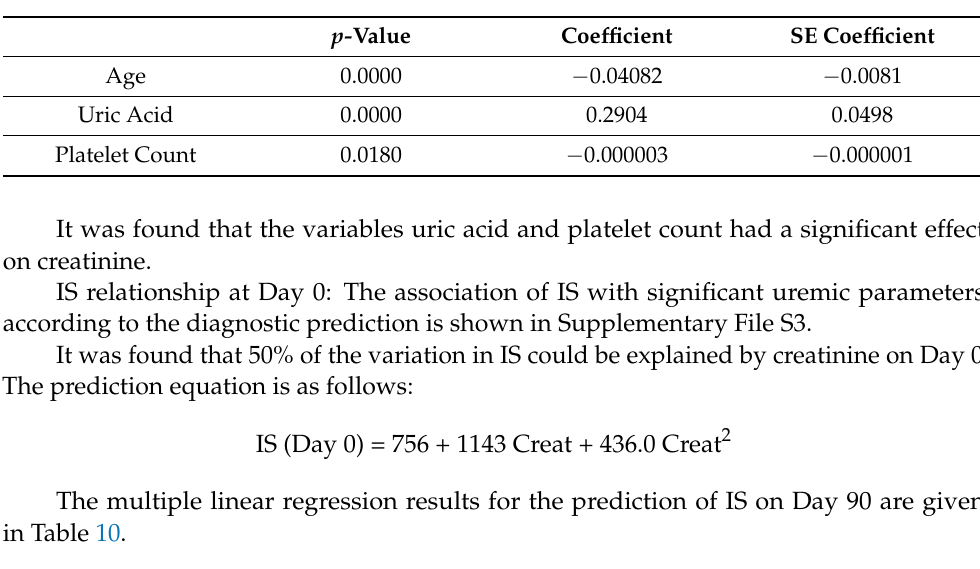
Table 10. IS (Day 90) prediction after treatment (enzobiotics and placebo) as a function of initial creatinine, urea, and phosphorus